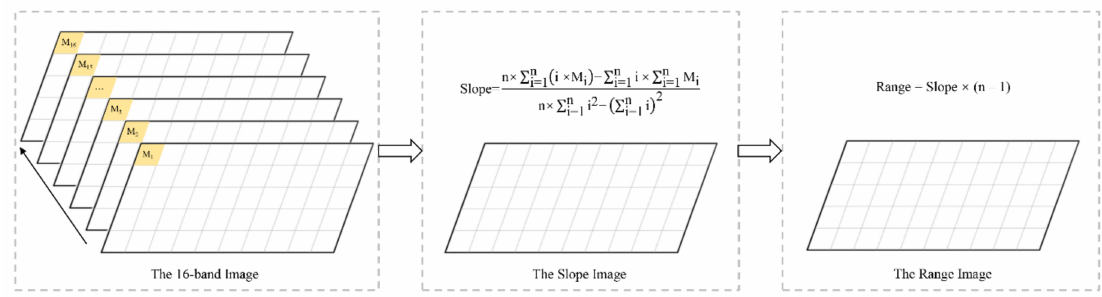
Figure 4. Workflow of the satellite image